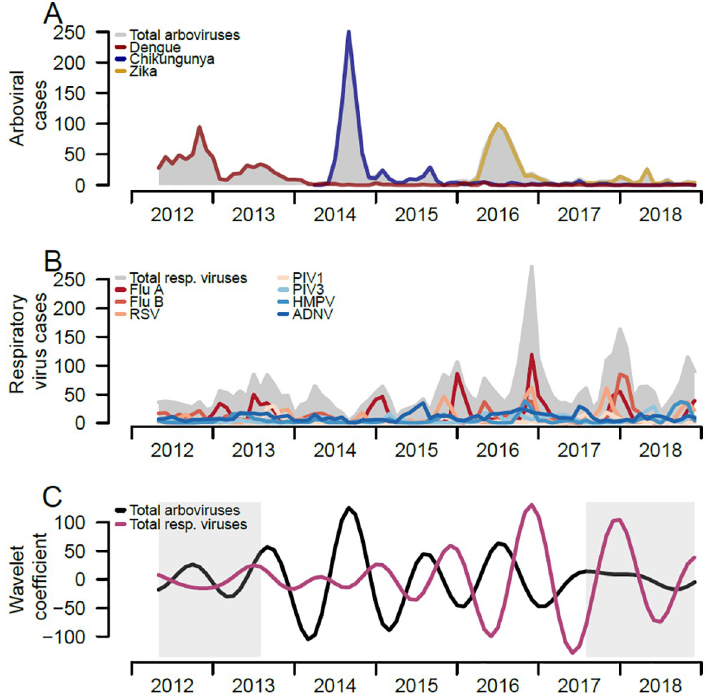
Fig 2. Trends of respiratory viruses and arboviruses among pediatric patients and comparison of both epidemic patterns, Sentinel Enhanced Dengue Surveillance System (SEDSS), Ponce, Puerto Rico, 2012–2018. A) Number of monthly RT-PCR confirmed respiratory viral infections overall and individually B) Number of monthly total and individual respiratory viral infections confirmed by RT-PCR. C) Reconstructed seasonal patterns of monthly total respiratory viral infections and arboviral infections using Morlet wavelet decomposition. Seasonal period was defined 8 to 16 months. Grey shading reflects the cone of influence, where the initial and last months of the seasonal time-series have more uncertainty (i.e. edge effects).